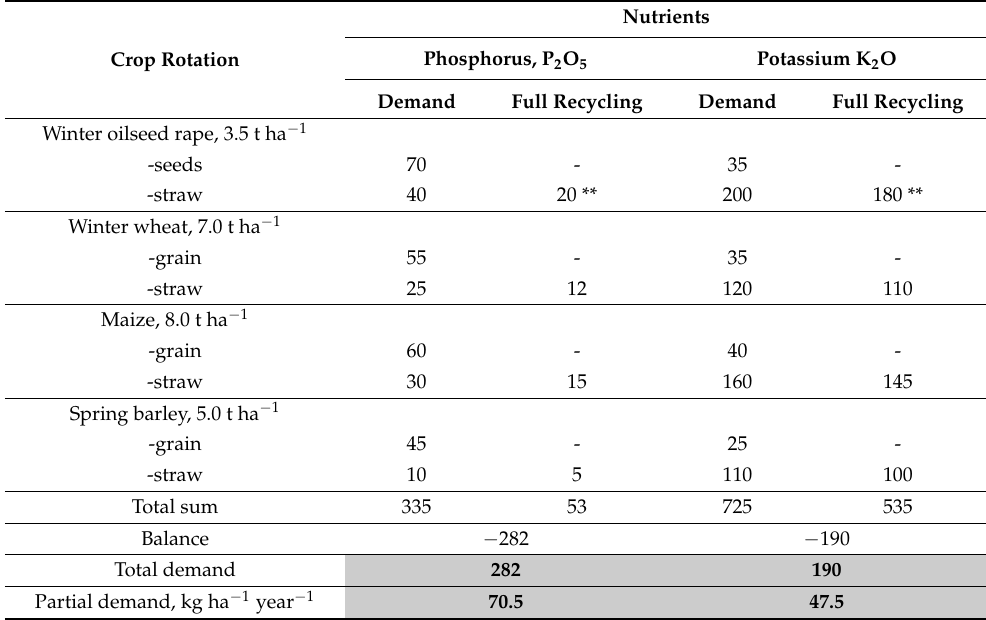
Figure 11. The crop rotation conceptual approach for the sufficient K level and range on sandy loam for sensitive and non-sensitive K plants. Legend: 1 CL ─ N-Sc, CL ─ Sc, CR ─ N-Sc, 2 CR ─ Sc: critical level and critical range for non-sensitive and sensitive plants to the content of available K (determined by the Egner – Riehm method). Table 1. Phosphorus and potassium balance in four-course rotation with winter oilseed rape. under full use of straw 1, *, t ha − 1